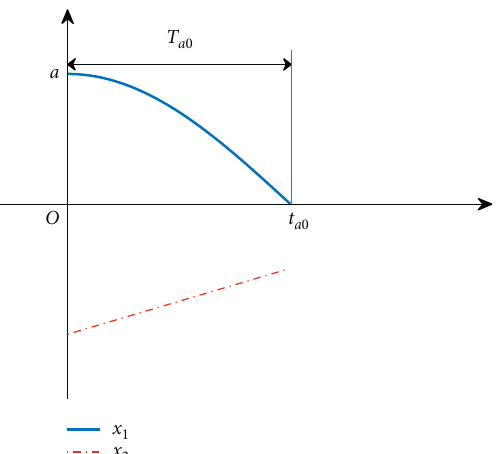
Figure 1: Trajectory of the STS with a ≠